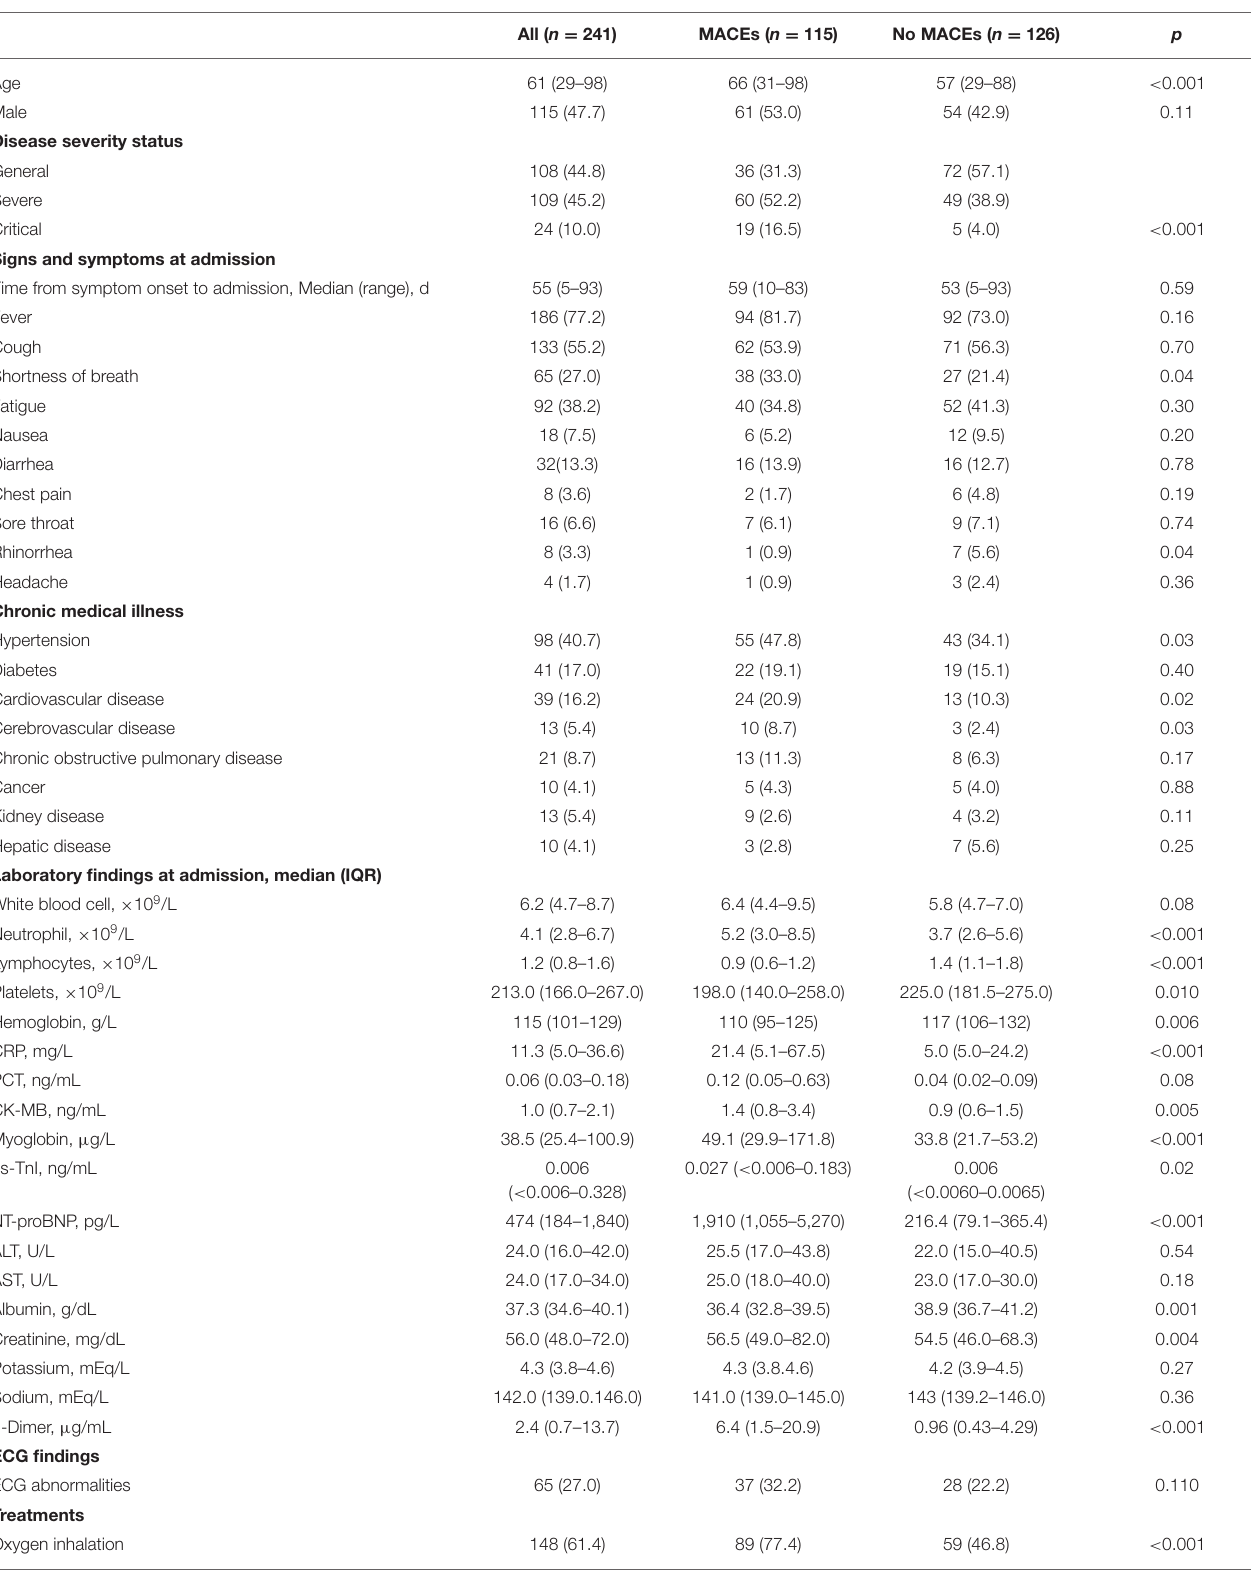
TABLE 1 | Demographic, clinical, and laboratory findings of patients with COVID-19 on